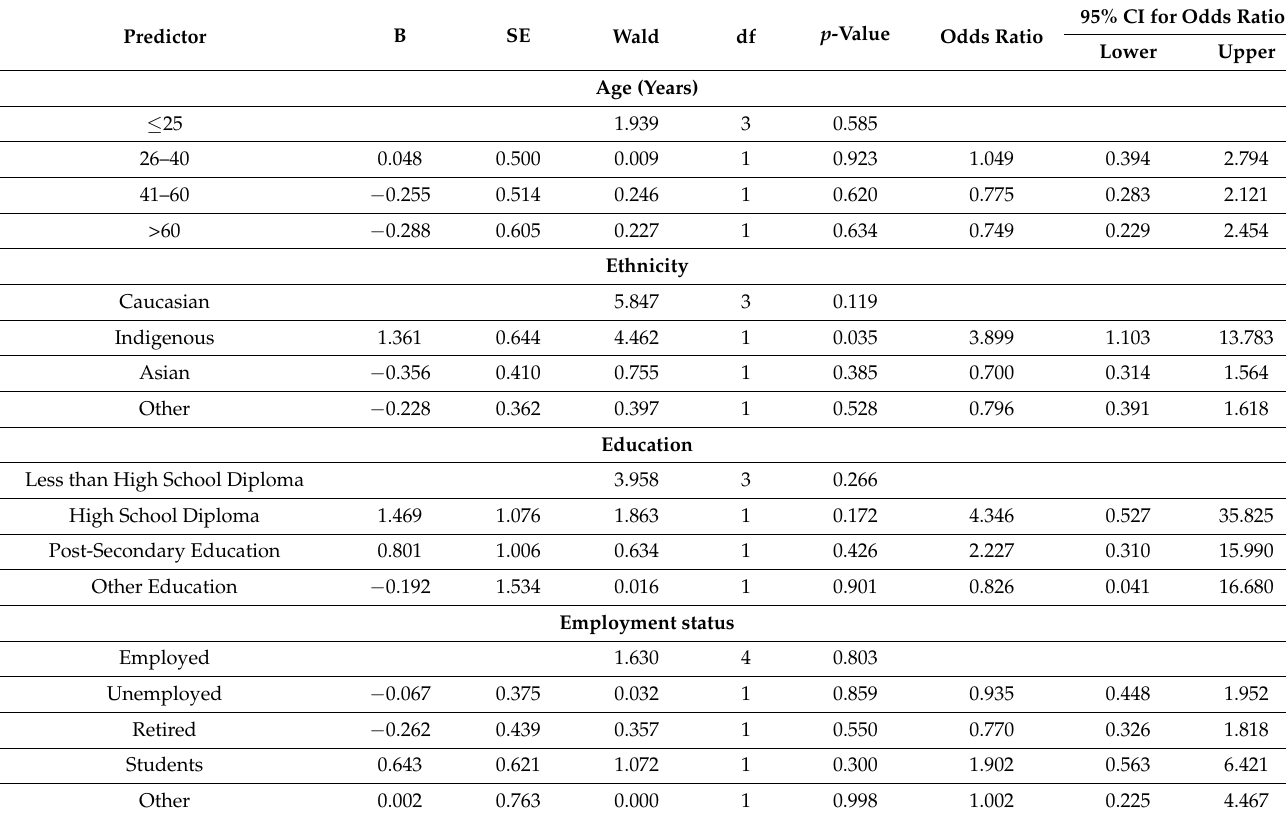
Table 4. Logistic regression predicting likelihood of respondents presenting with